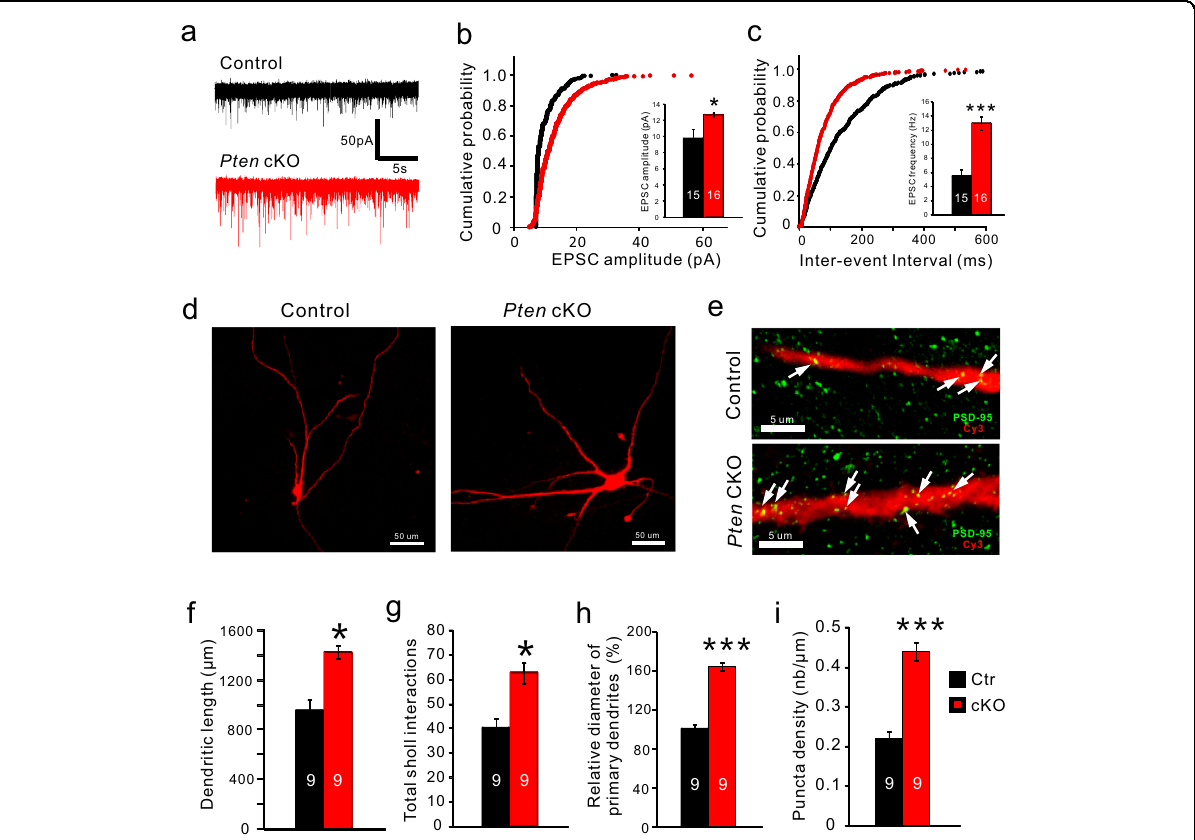
Fig. 3 Dendritic complexity and excitatory input are increased in Pten -de fi cient 5-HT neurons. a Raw data traces of spontaneous excitatory postsynaptic current (sEPSC) recorded from 5-HT neurons in the dorsal raphe nucleus of control and Pten cKO mice. b, c Cumulative probability histograms show the distribution of amplitude and inter-event interval of sEPSCs events recorded from control and Pten -de fi cient 5-HT neurons. The inset shows the average amplitude and frequency of all sEPSCs are signi fi cantly increased in Pten -de fi cient 5-HT neurons ( N = 7 mice for each group; n = 15 neurons in control and n = 16 neurons in Pten cKO mice). d Morphology of 5-HT neurons fi lled with biocytin (red) in control and Pten cKO mice. Scale bars = 50 μ m. e . Immunostaining of PSD-95 (green) in primary dendrites of 5-HT neurons in the dorsal raphe nucleus of control and Pten cKO mice. Scale bars = 5 μ m. f , g Total dendritic length, and branching are shown by Sholl analysis are increased in 5-HT neurons of Pten cKO mice compared with controls. h The diameter of primary dendrites of 5-HT neurons is increased in Pten cKO mice compared with controls. i The density of PSD-95 + puncta on primary dendrites of 5-HT neurons is increased in Pten cKO mice compared with controls. Nine biocytin- fi lled neurons from 7 mice for each genotype were used for statistical analysis in ( f, g, h , and i ). All the data are presented as the mean ± s.e.m. * p < 0.05, *** p <